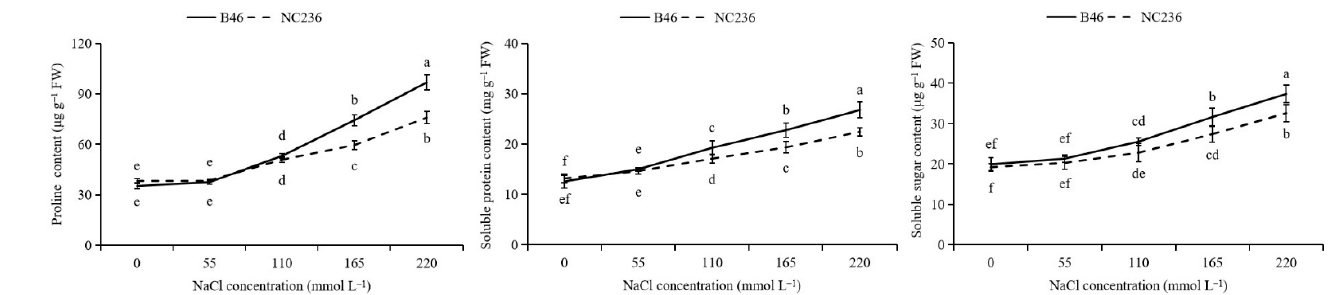
Figure 9. Effects of salt stress on the contents of proline, soluble protein, and soluble sugar in maize leaves. Data are expressed as mean ± standard deviation. Different letters within the same column indicate significant difference at the 5% level.